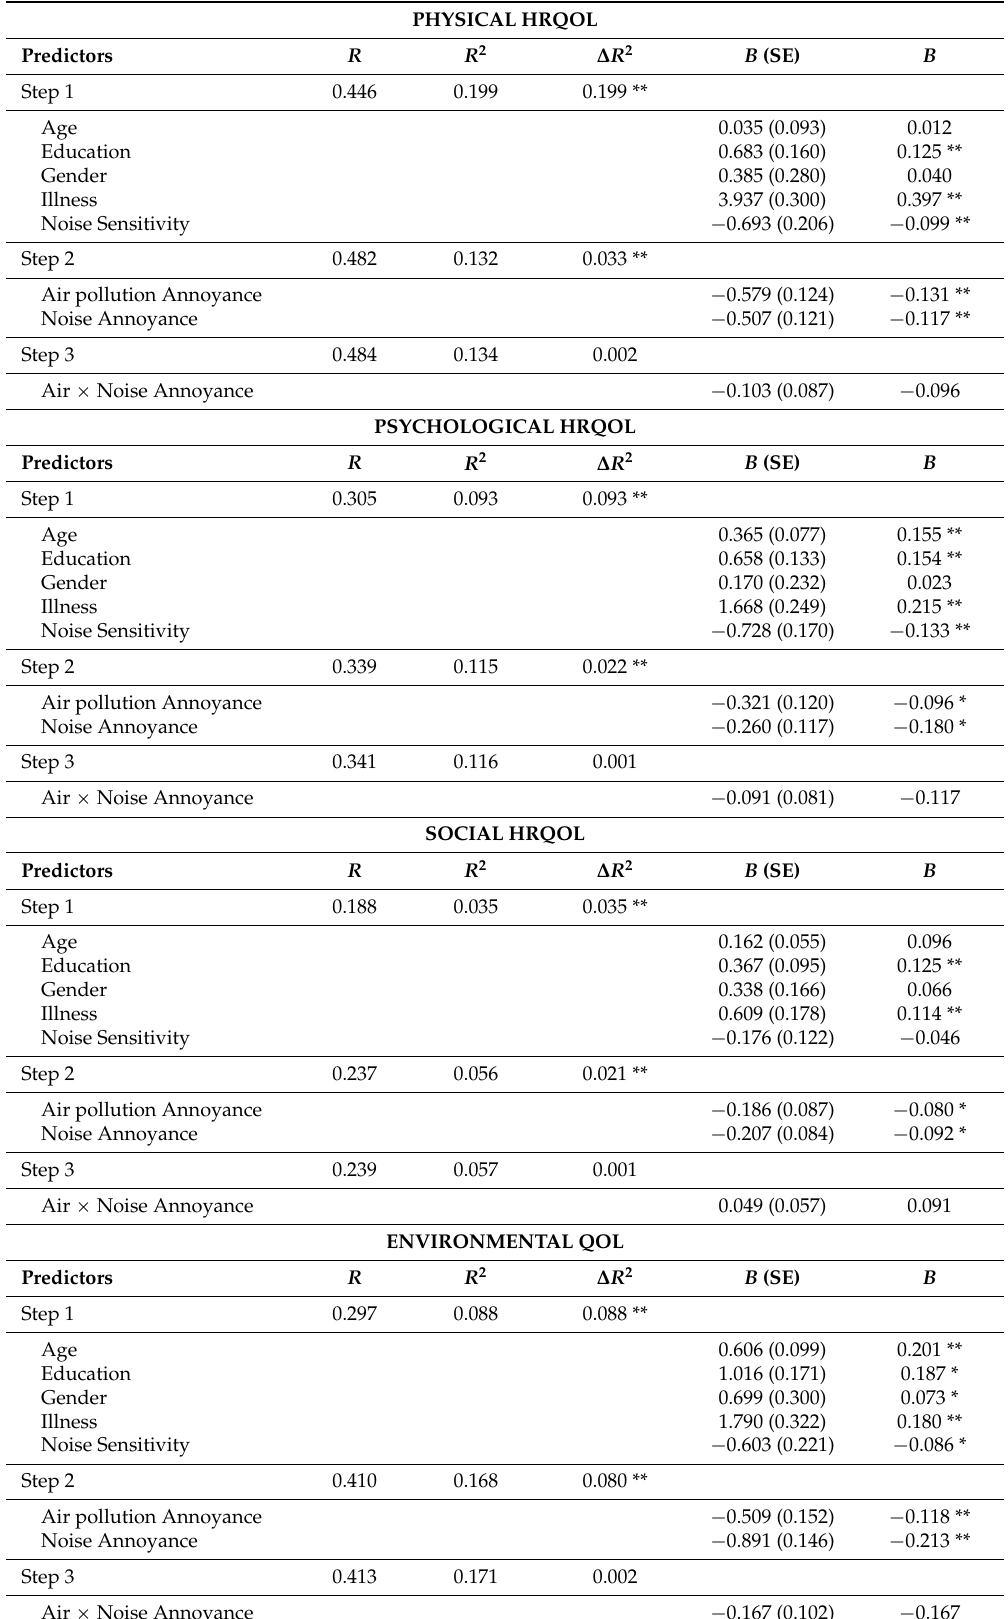
Table 3. Results of multiple linear regression analysis (* p < 0.05, ** p <